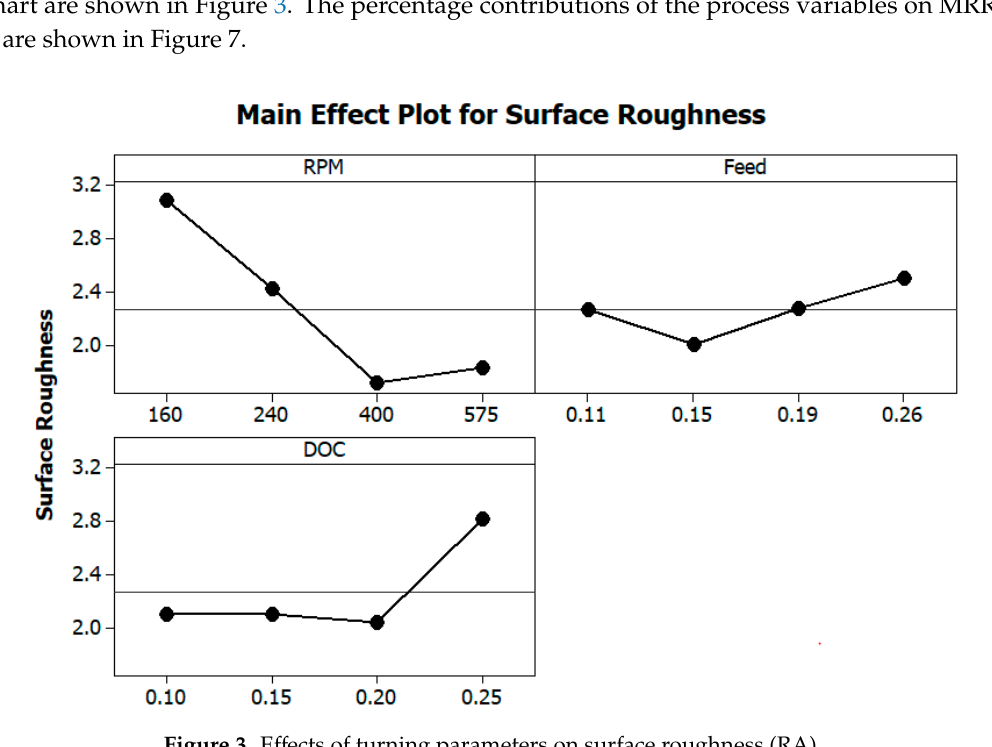
Figure 3. Effects of turning parameters on surface roughness (RA). Figure 3. E ff ects of turning parameters on surface roughness